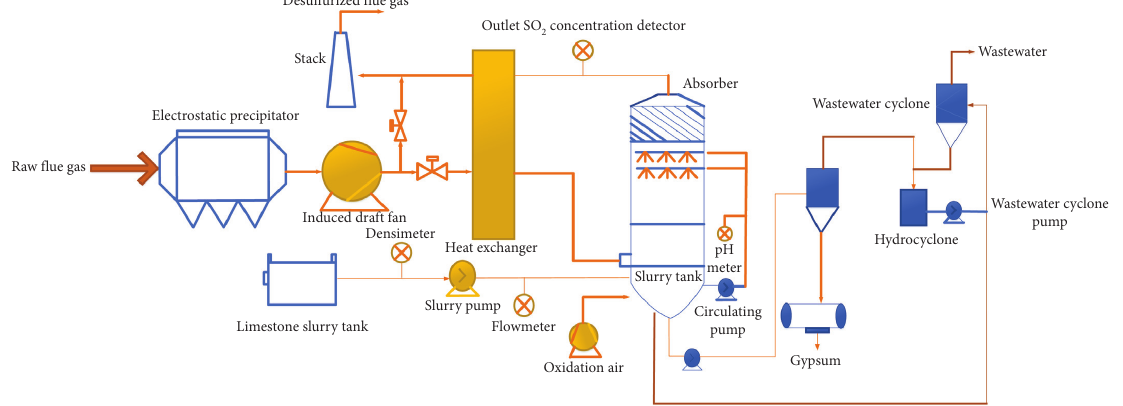
Figure 1: Schematic diagram of wet flue gas desulphurization system.